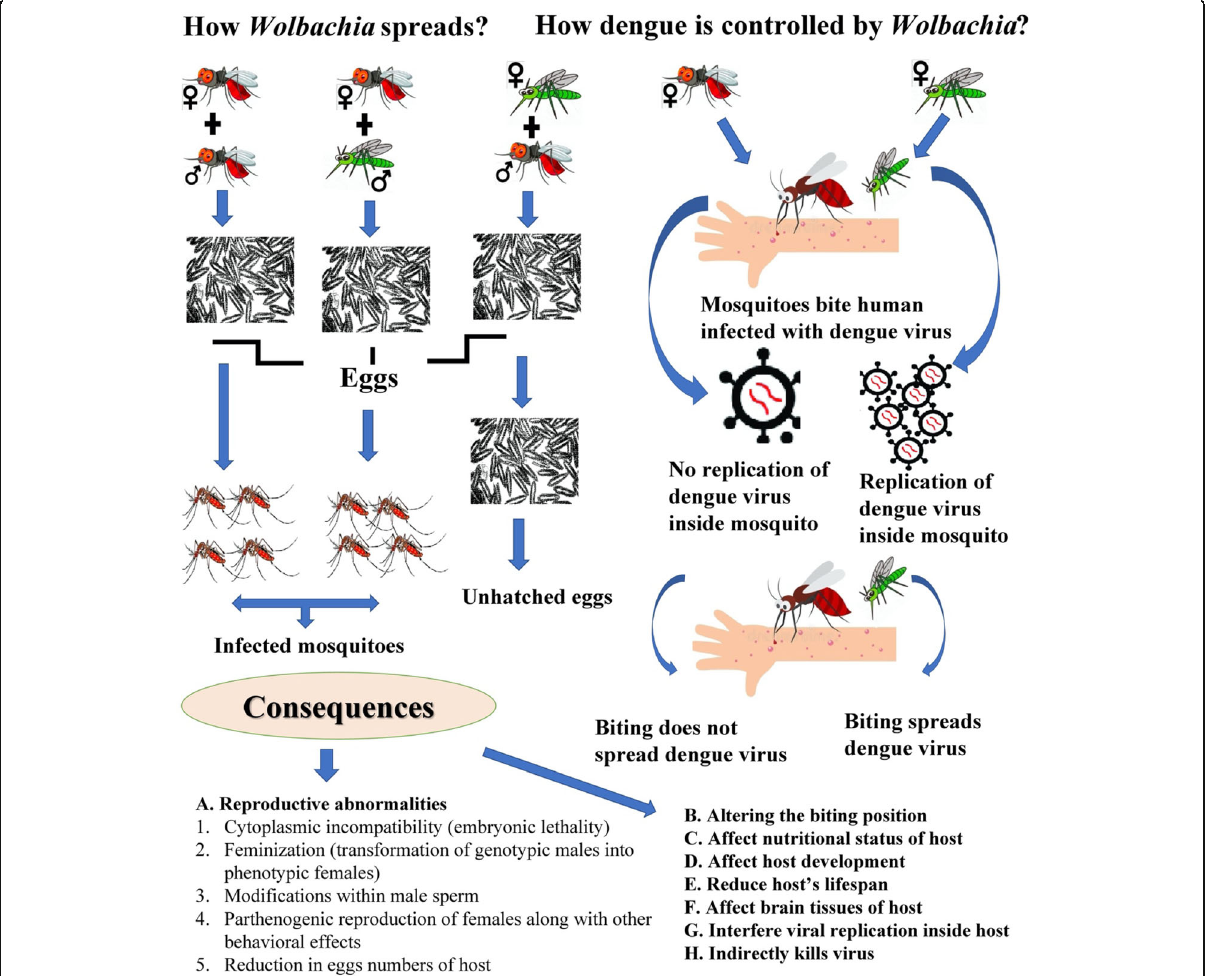
Fig. 3 Vertical transmission of Wolbachia , its role in controlling dengue [23], and consequences within the infected host [24]. Note: red colored mosquitoes are infected with Wolbachia while green colored mosquitoes are uninfected. ♀ indicates female mosquito and ♂